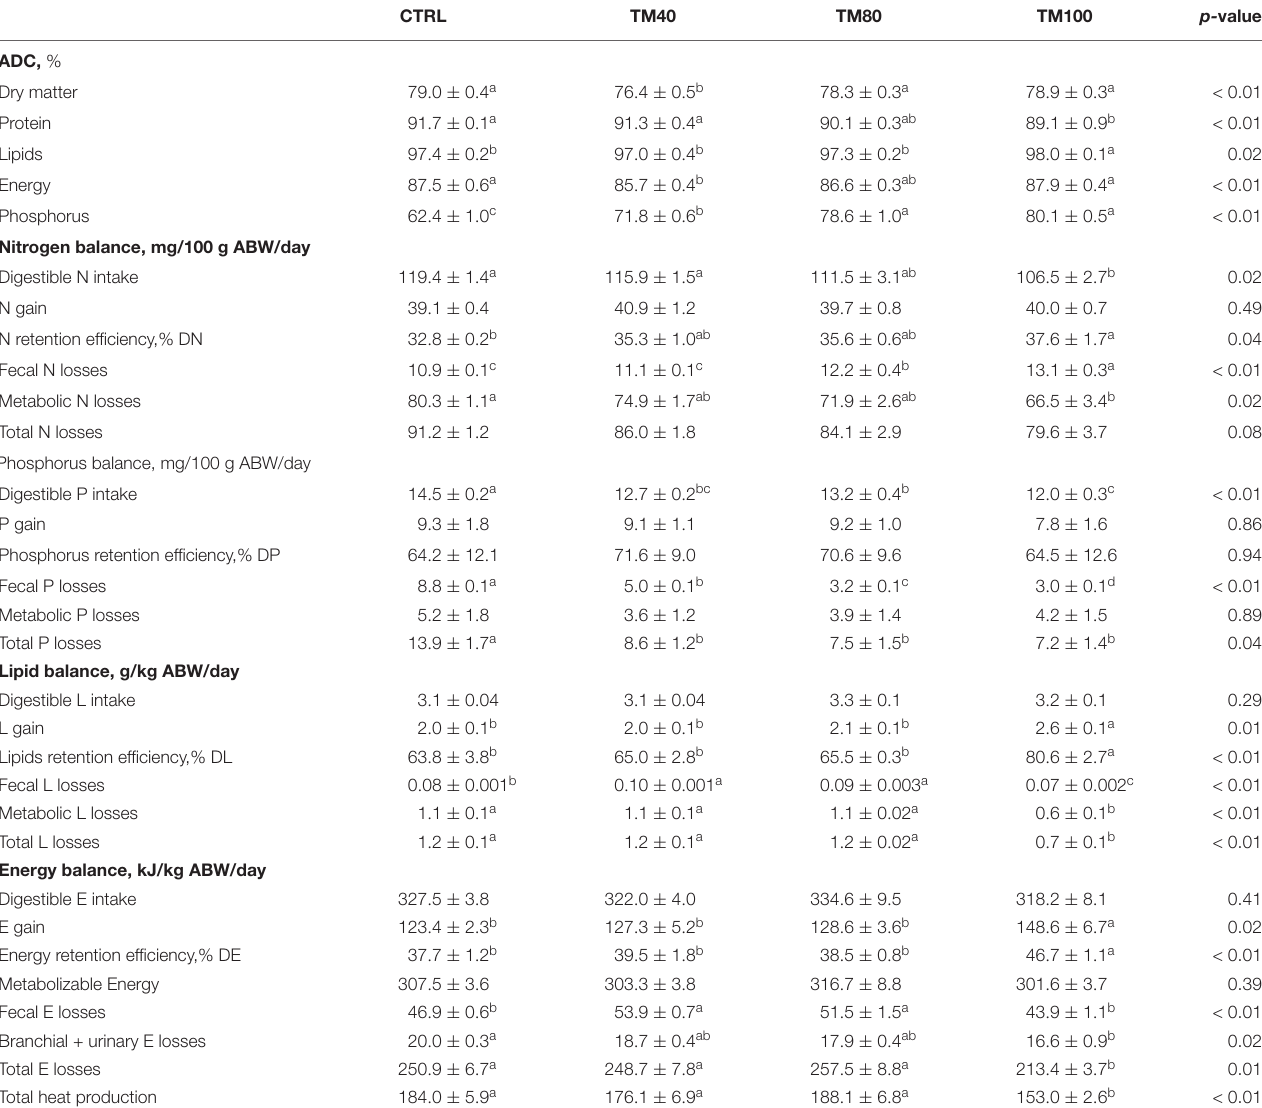
TABLE 4 | Apparent digestibility coefficients and nutrient balances of European sea bass fed experimental